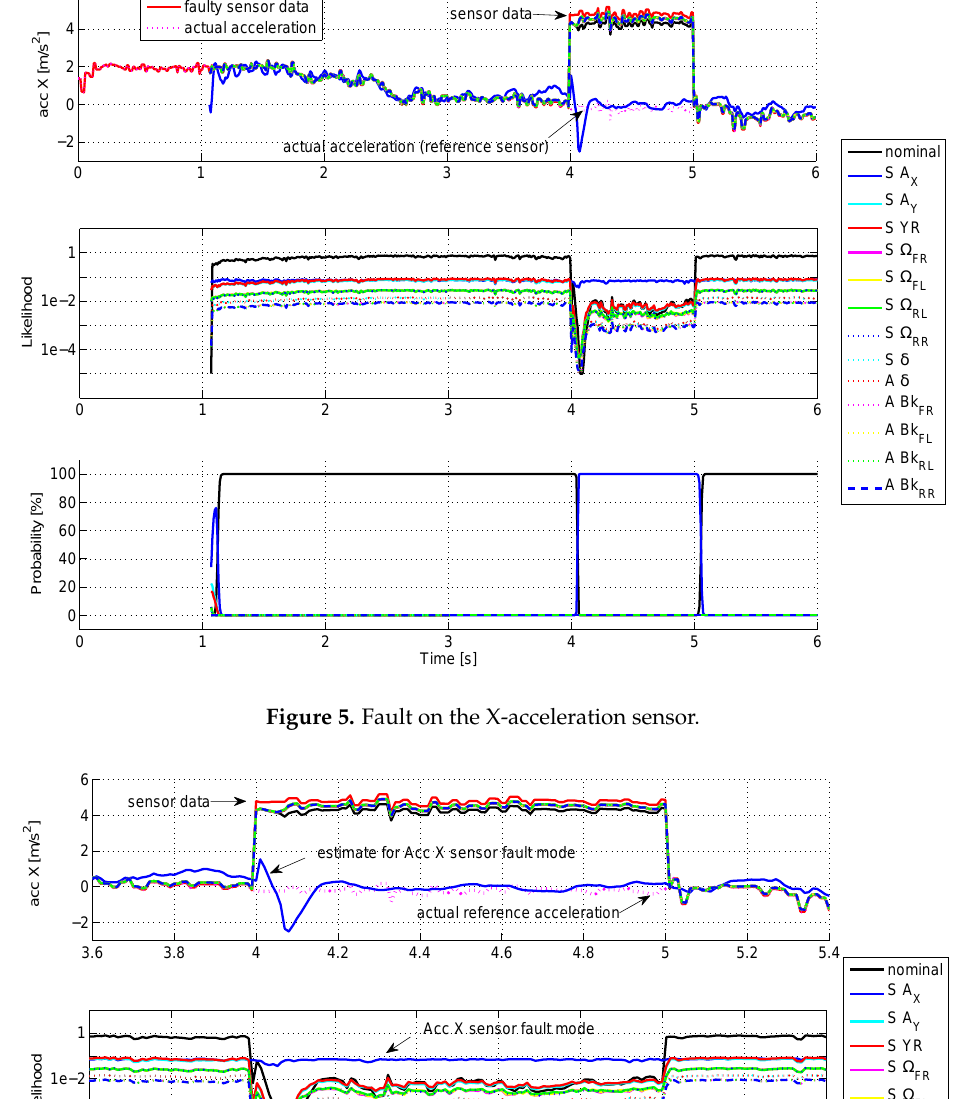
Figure 5. Fault on the X-acceleration sensor.